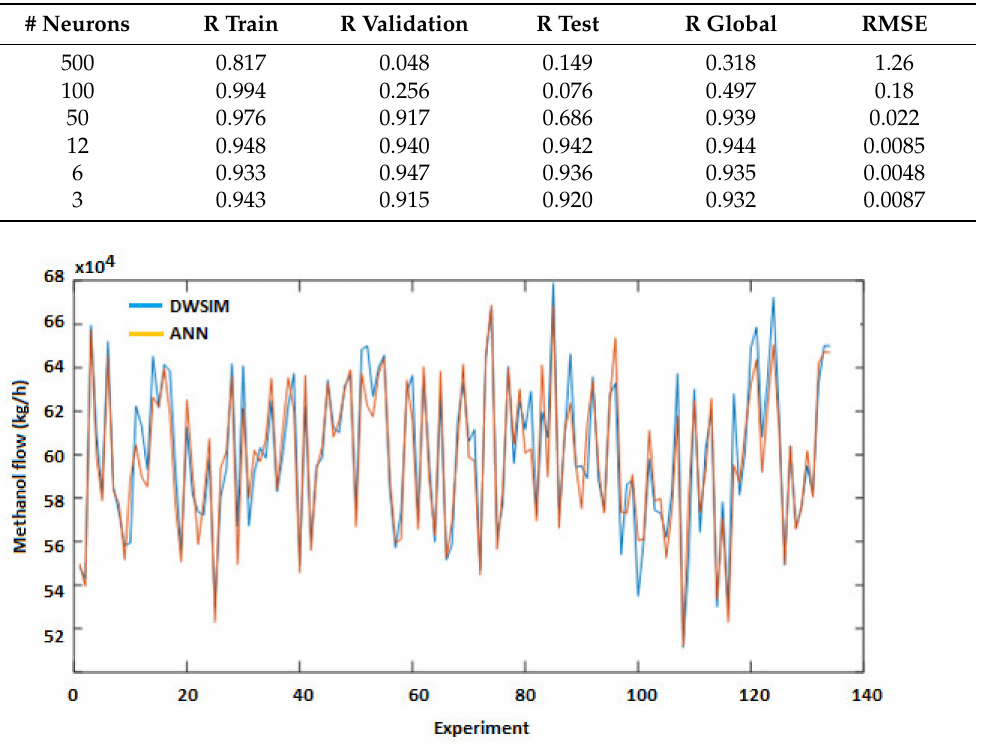
Figure 8. Regression and correlation coefficient using 12 neurons in the hidden layer for stage ( a ) the training phase, ( b ) validation, ( c ) testing, and ( d ) overall. Table 9. R and RMSE values for trial and error using LM algorithm.